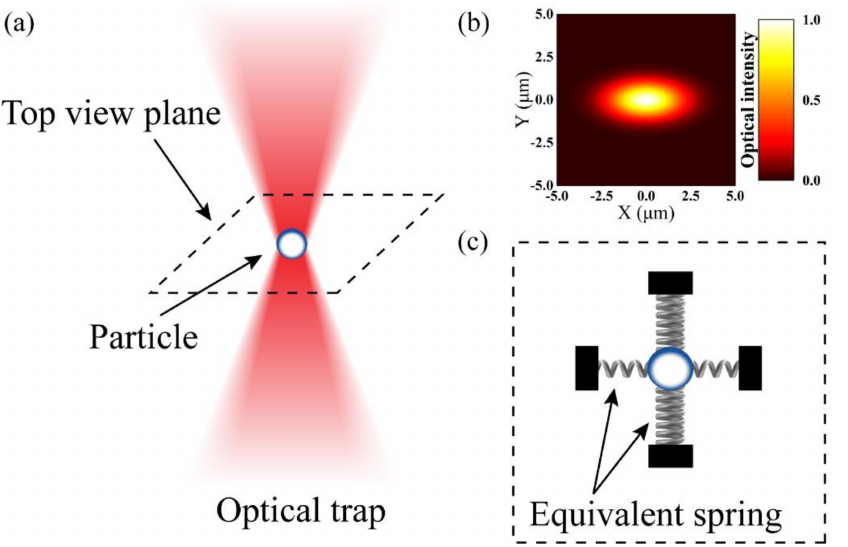
Figure 2. Schematic diagram of the optical force dual-axis accelerometer. ( a ) A single-beam optical trap used to levitate a particle; ( b ) Optical field distribution at the focus plane of one laser diode; ( c ) Equivalent spring oscillator model at the focal